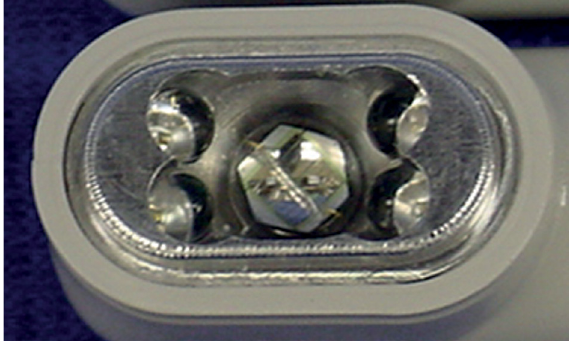
Figure 28. Image of the construction of the emitting elements in Ultradent’s Ultralume 5 curing light.